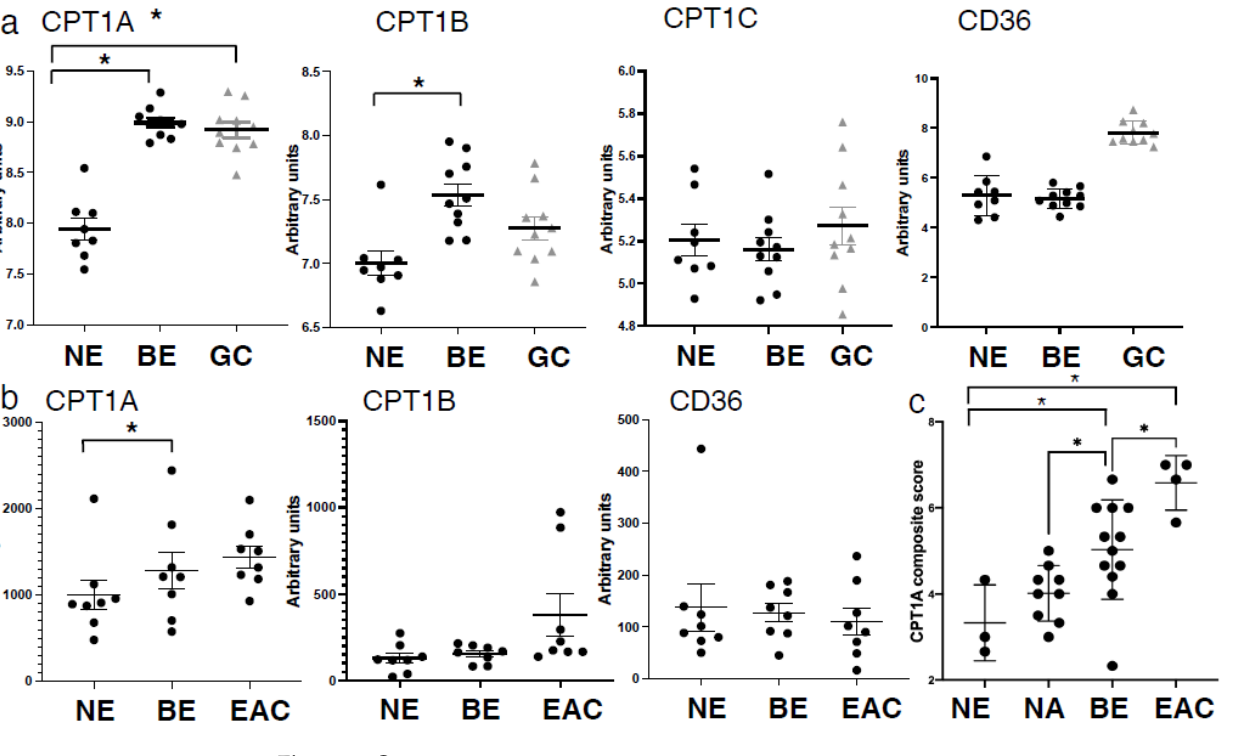
Figure 1. Expression of CPT1A is increased in the sequence from normal esophageal squamous ep- ithelium to BE and EAC. ( a ) Comparison of CPT1 component expression and CD36 between normal esophagus (NE), Barrett’s esophagus (BE) and gastric cardia (GC) using the GSE34619 dataset (8 patients normal squamous, 10 with BE and 10 gastric cardia). * p < 0.05 Student’s t -test ( b ). Expres- sion of CPT1A, CPT1B and CD36 in normal esophagus (NE), Barrett’s esophagus (BE) and esopha- geal adenocarcinoma (EAC) tissues in the publically available dataset GDS1321/GSE1420;8 patients with Barrett’s associated adenocarcinomas. ( c ) Composite score and quantification of immunofluo- rescent staining using antibody against CPT1A in normal esophagus (NE), Barrett’s esophagus (BE) and esophageal adenocarcinoma (EAC) and matching normal adjacent tissues (NA). ( d ) Representa- tive images of CPT1A immunofluorescence staining. * p < 0.05, Student’s t -test.